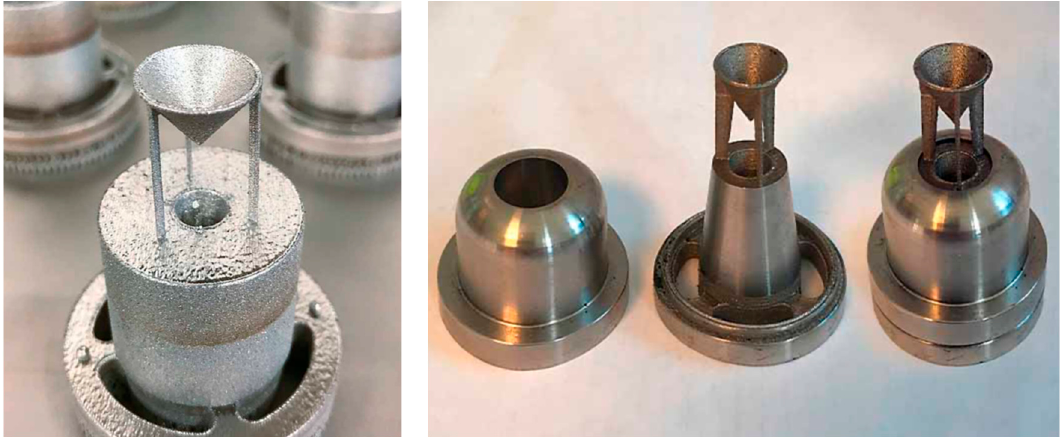
Figure 19. Nozzle manufactured by Wärtsilä [56].